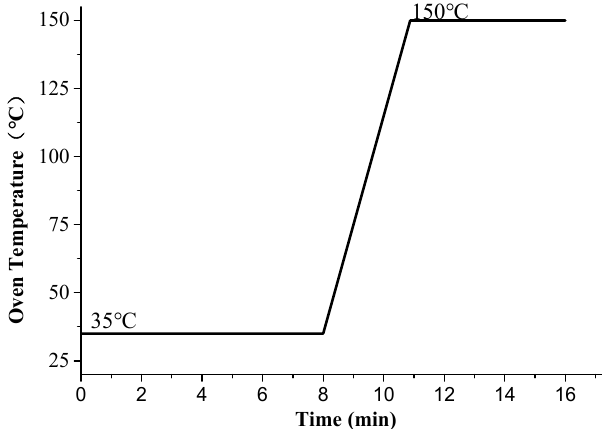
Figure 2. Oven temperature of GC-MS (gas chromatography mass spectrometry).